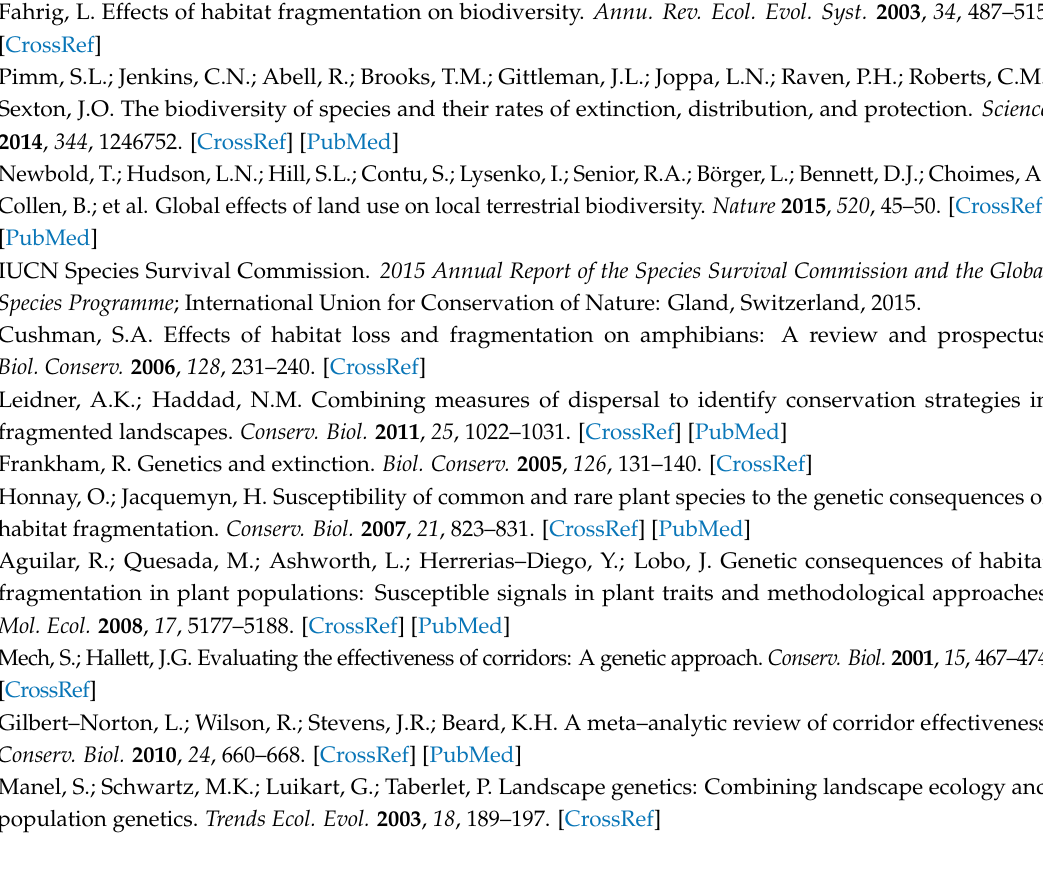
Figure S1: Spatial patterns of observed heterozygosity, Figure S2: Spatial patterns of expected heterozygosity, Figure S3: Relationship between observed heterozygosity and landscape connectivity, Figure S4: Relationship between expected heterozygosity and landscape connectivity, Table S1: Relationship between D ps and resistance distance, Table S2: Relationship between effective population size (Ns) and connectivity, Table S3: Relationship between allelic richness (A r ) and connectivity, Table S4: Relationship between observed heterozygosity (H o ) and connectivity, Table S5: Relationship between expected heterozygosity (H e ) and